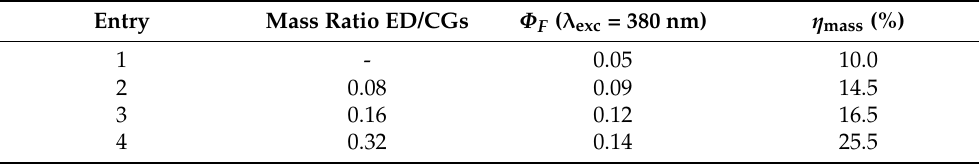
Table 4. Effect of ED content on the C-dots’ luminescence and reaction yield 1 .